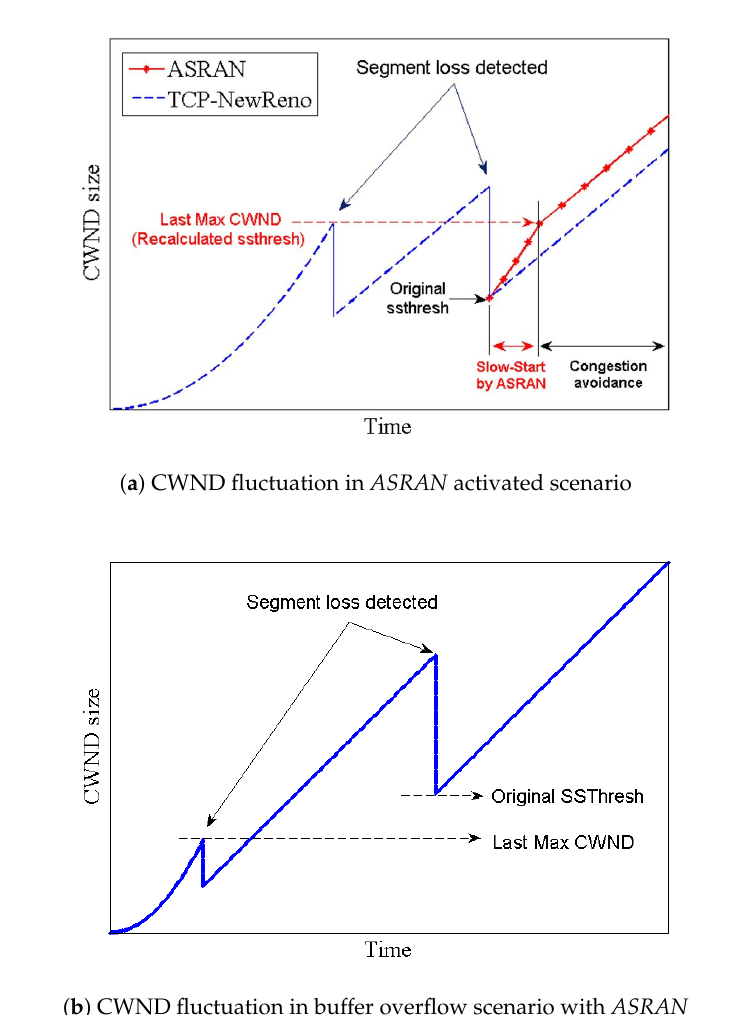
Figure 2. CWND fluctuation of ASRAN in transient link instability and buffer overflow